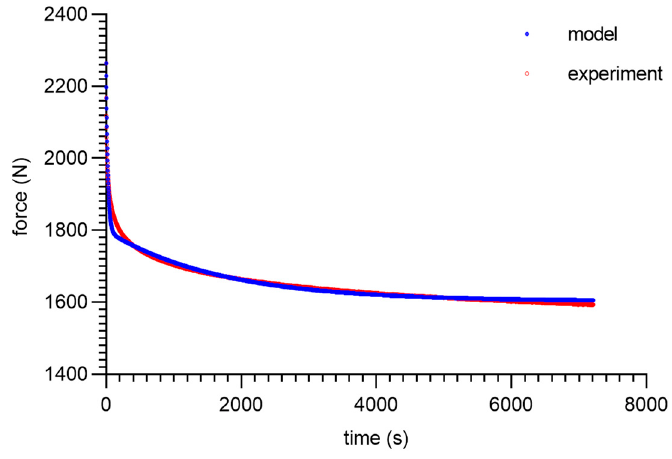
Figure 15. Material 90 ShA—five-parameter relaxation model and experimental data for ε = 100% .